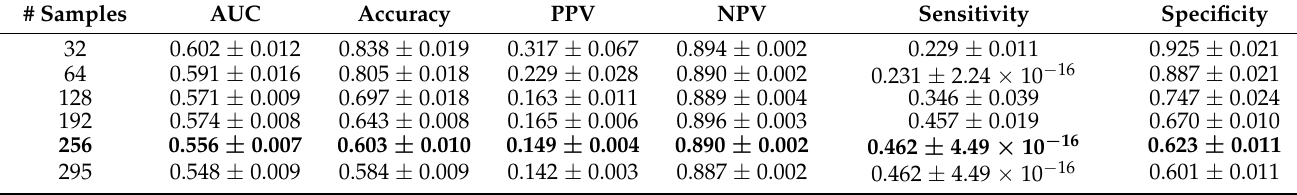
Table 4. Results for the benign vs. malignant primary nodule classification (Aim 2) achieved by the classifiers fitted (in nested 5-fold CV) on the blinded test set for the Borderline-SMOTE method. The metrics are expressed as average ± standard deviation. The rows in boldface denote the best performing configuration according to sensitivity and